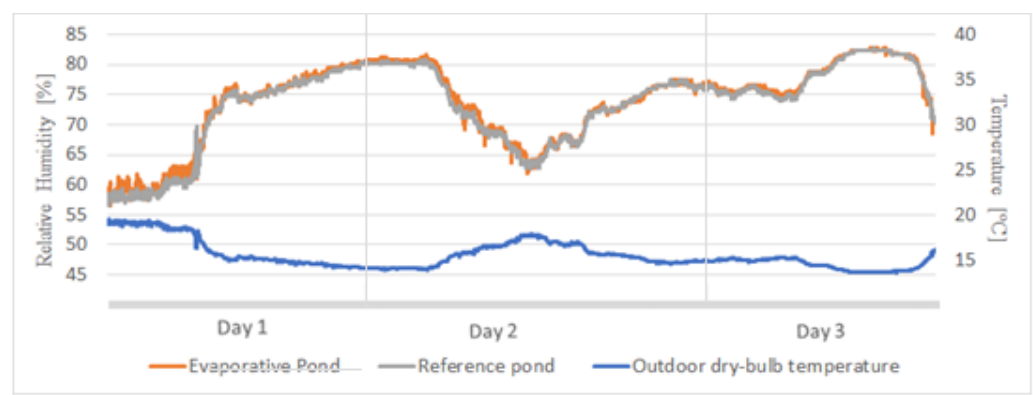
Figure 7. Relative humidity and dry-bulb temperature fluctuation in the ponds (experiment 1).